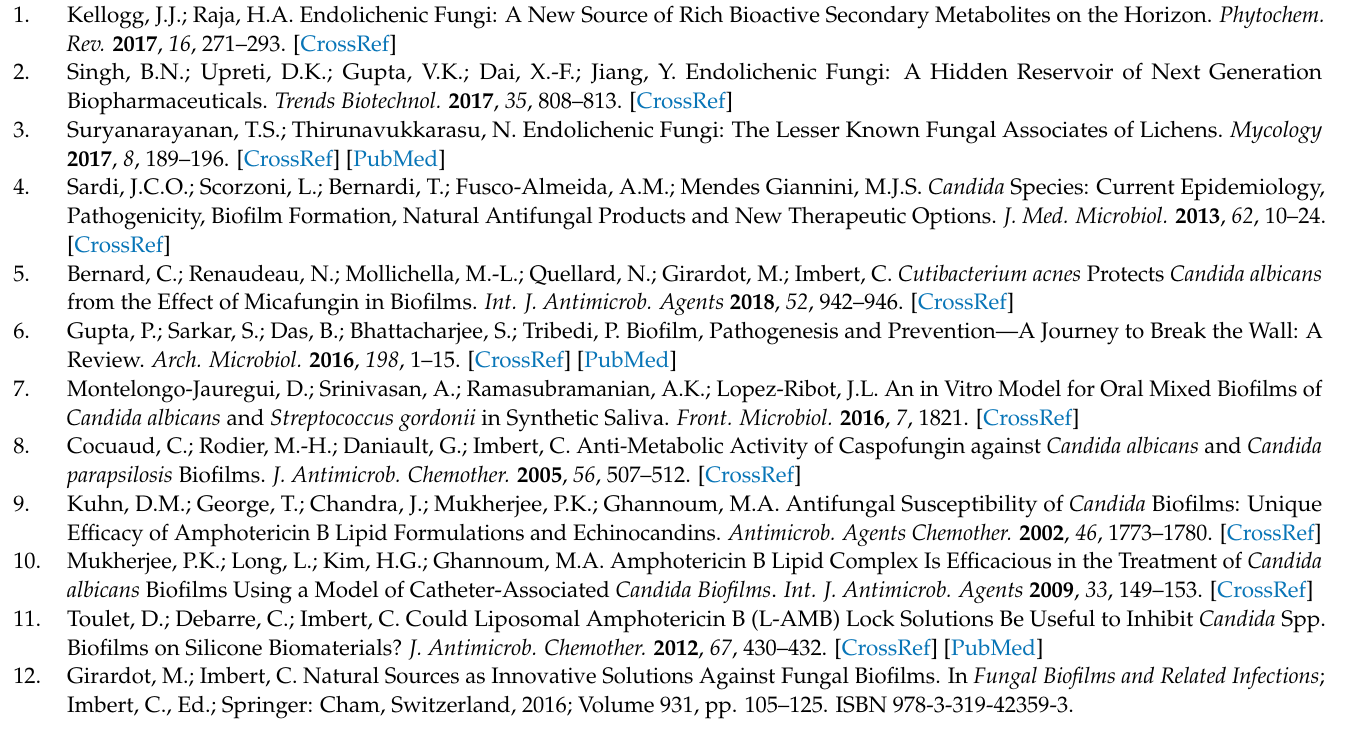
Figure S21: peak area of the three major peaks for m/z 311.2220 in the different extracts of Preussia species; Figure S22: 1 H NMR spectrum for compound 8Z-5,6-epoxy-4-hydroxy-octadec-8-enoic acid; Figure S23 and S24: 13 C NMR spectra for compound 8Z-5,6-epoxy-4-hydroxy-octadec-8-enoic acid; Figure S25 and S26: 2D NMR COSY spectra for compound 8Z-5,6-epoxy-4-hydroxy-octadec-8-enoic acid; Figure S27 and S28: 2D NMR HSQC spectra for compound 8Z-5,6-epoxy-4-hydroxy-octadec- 8-enoic acid; Figure S29 and S30: 2D NMR HMBC spectra for compound 8Z-5,6-epoxy-4-hydroxy- octadec-8-enoic acid; Table S1: fungal strains description; Table S2: endolichenic fungi